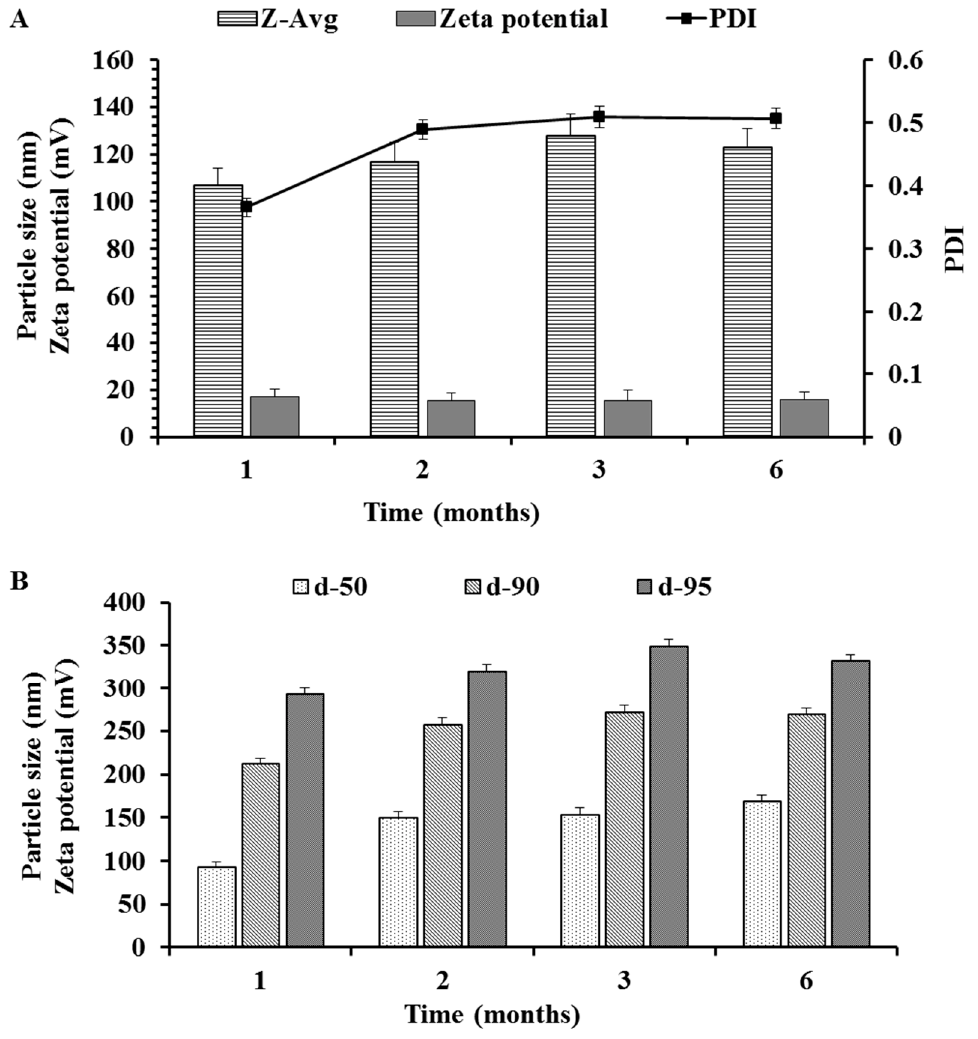
Figure 6. Stability of the particles as a function of time at 4 °C. ( A ) Particle size as the Z-average, polydispersity index (PDI) and zeta potential. ( B ) Particle sizes of d50, d90, d95.